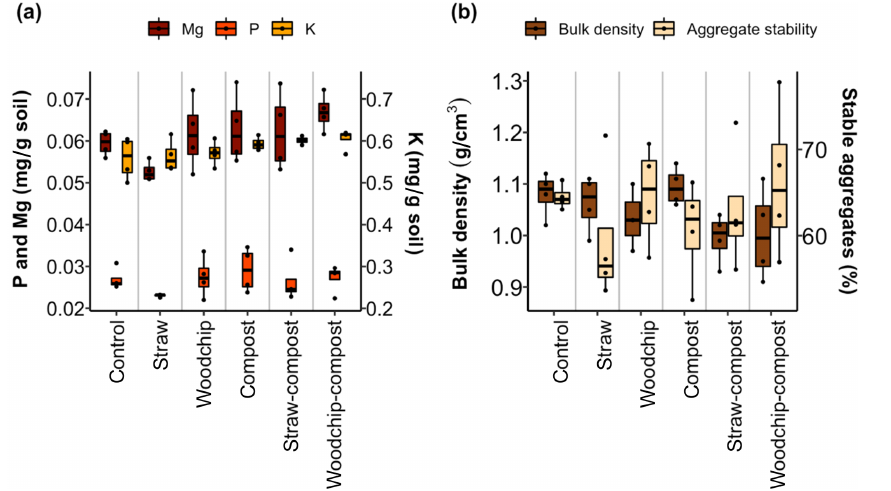
Figure 5. (a) Available nutrients after each soil amendment treatment. (b) Soil physical properties after each treatment. Lower and upper hinges correspond to the 25th and 75th percentiles; black dots represent individual data points, which occasionally overlap ( n = 4). Table 5. Selected Pearson correlations ( r values). Significance indicated as ∗∗ p< 0 . 05 and ∗ p< 0 . 10. Yield Av. N Av. and Min. N P Mg SOM Resp.